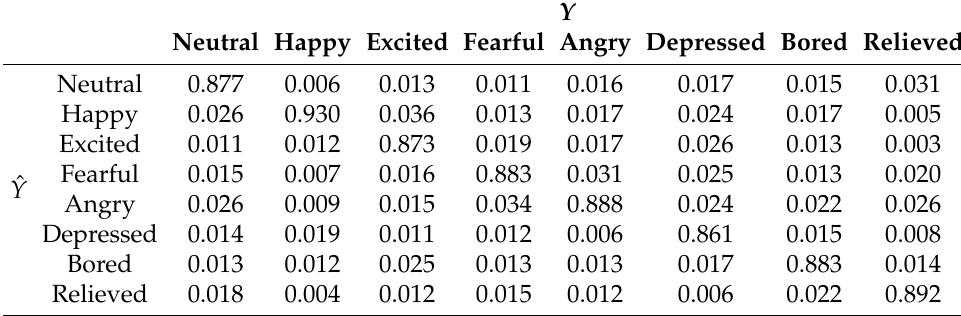
Table 6. Confusion matrix of the evaluate result of VAE ( 9,1024 ) .